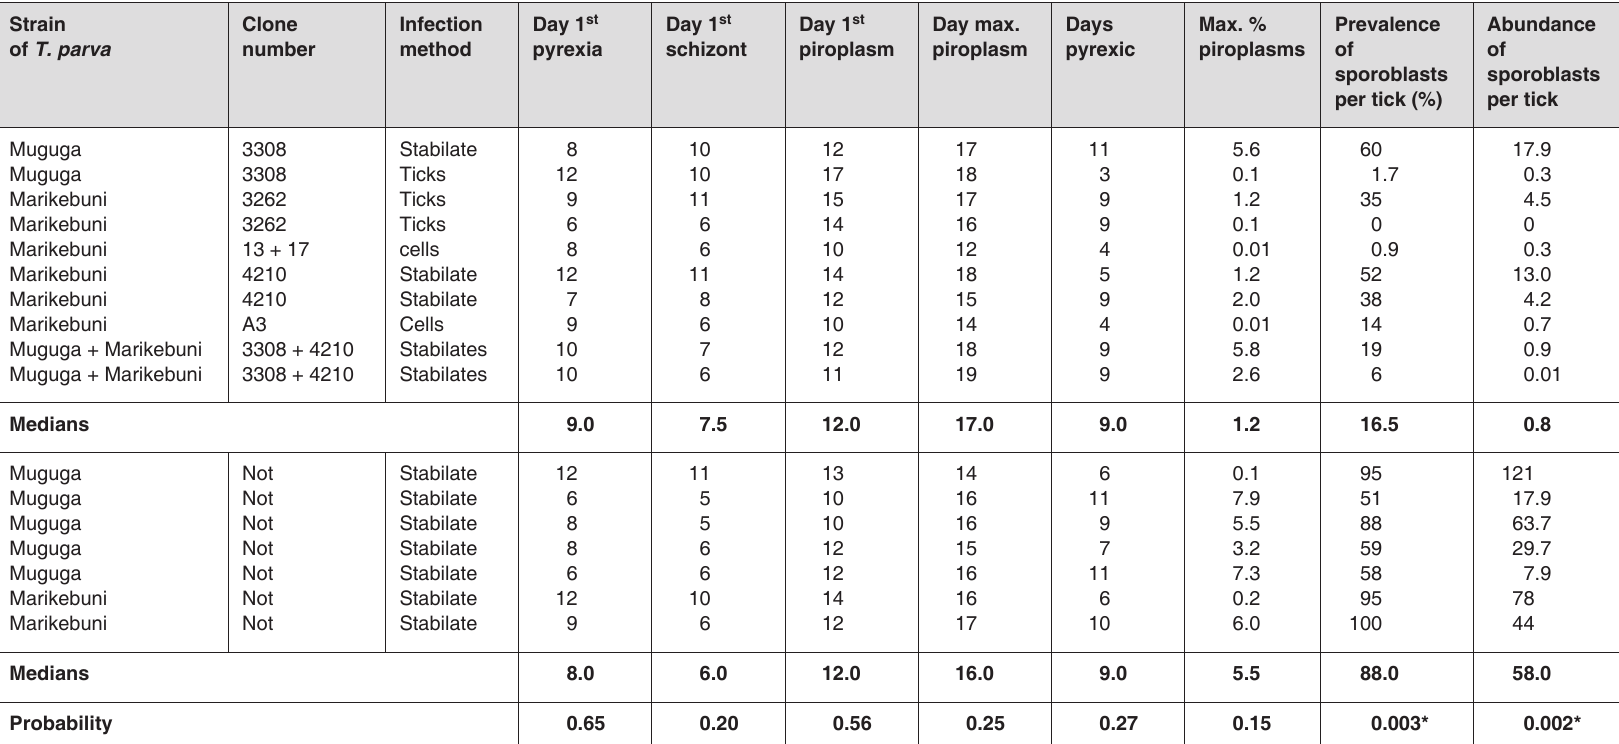
TABLE 1 Infection characteristics of cloned compared to uncloned T. parva in cattle and Ticks. Ten transmissions with cloned T. parva and seven transmissions with uncloned T. parva , all meeting the criteria of patent disease with pyrexia and production of piroplasms. Analysis by Mann-Whitney U test Strain of T.